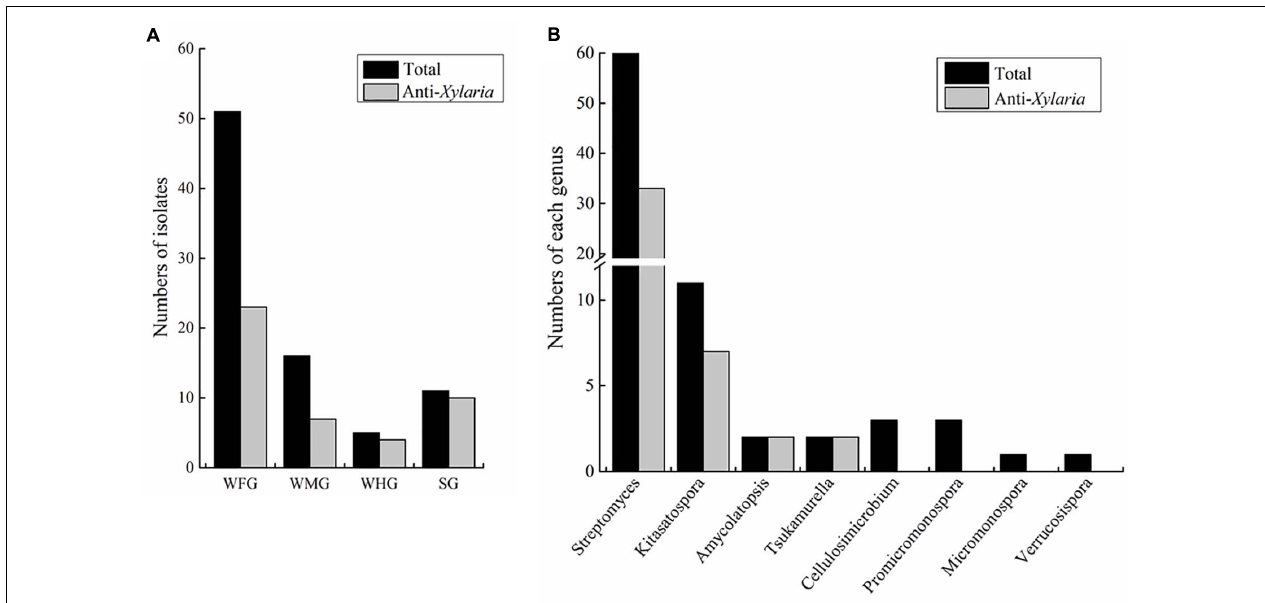
FIGURE 1 | Statistics of Actinobacteria isolated from intestines of Macrotermes barneyi . (A) Total numbers of Actinobacteria isolates and those with anti- Xylaria activity from the worker foregut (WFG), worker midgut (WMG), worker hindgut (WHG), and the soldier gut (SG), respectively. (B) Numbers of Actinobacteria isolates and those with anti- Xylaria activity in each genus. The anti- Xylaria activity was examined by the paired challenge assay.